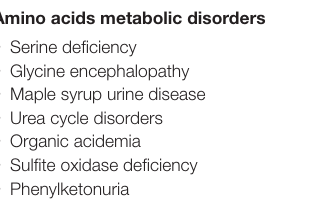
TABLE 1 | Metabolic disorders presenting with